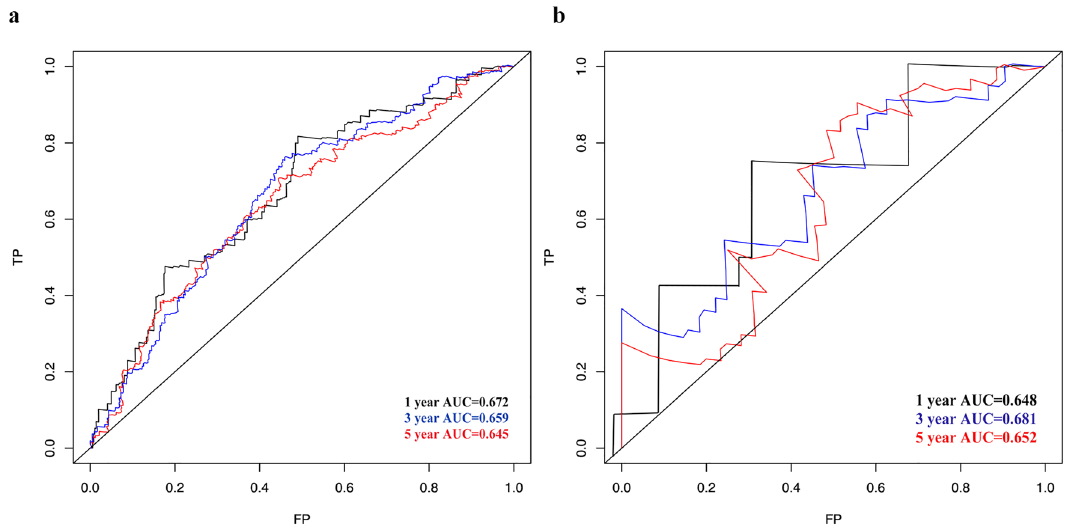
Figure 7. ROC for 1-, 3-, and 5-year overall survival predictions for the nomogram. ( a ) In the training cohort, ROC curve for 1-year, 3-year and 5-year overall survival. ( b ) In the validation cohort, ROC curve for 1-year, 3-year and 5-year overall